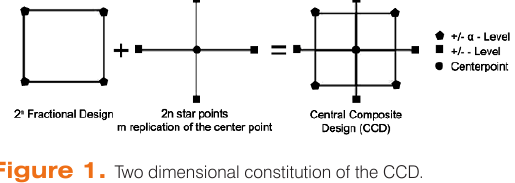
Figure 1. Two dimensional constitution of the CCD.